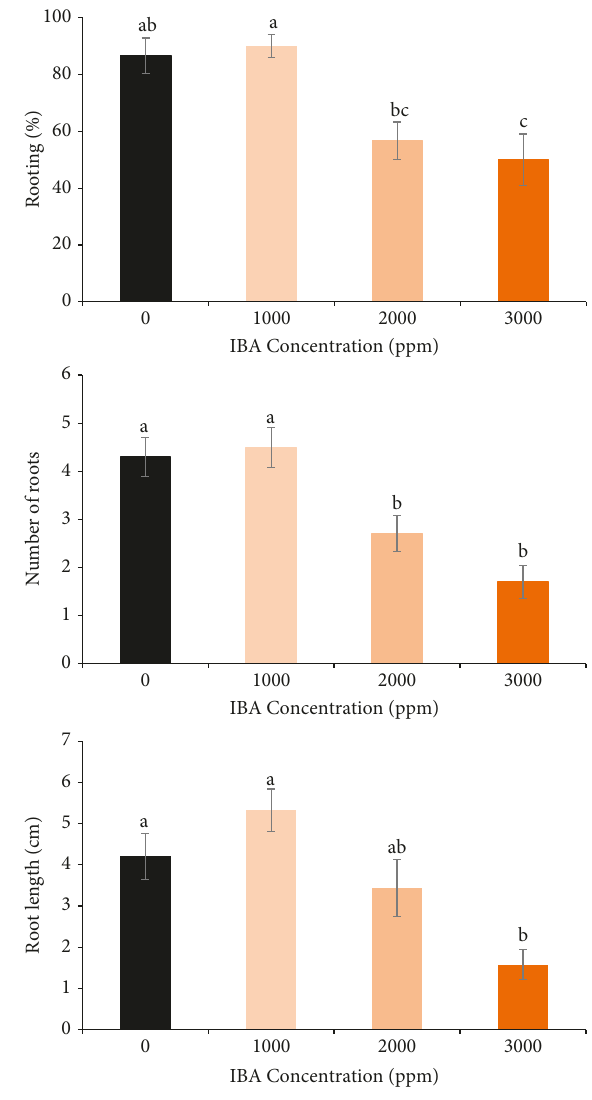
Figure 3: Survival percentage of T. cacao cuttings according to IBA dose, 62 days after rooting induction. Columns with the same letter indicate nonsignificant differences between the treatments (Tukey’s HSD, p < 0 . 05). Means and standard error ( n �